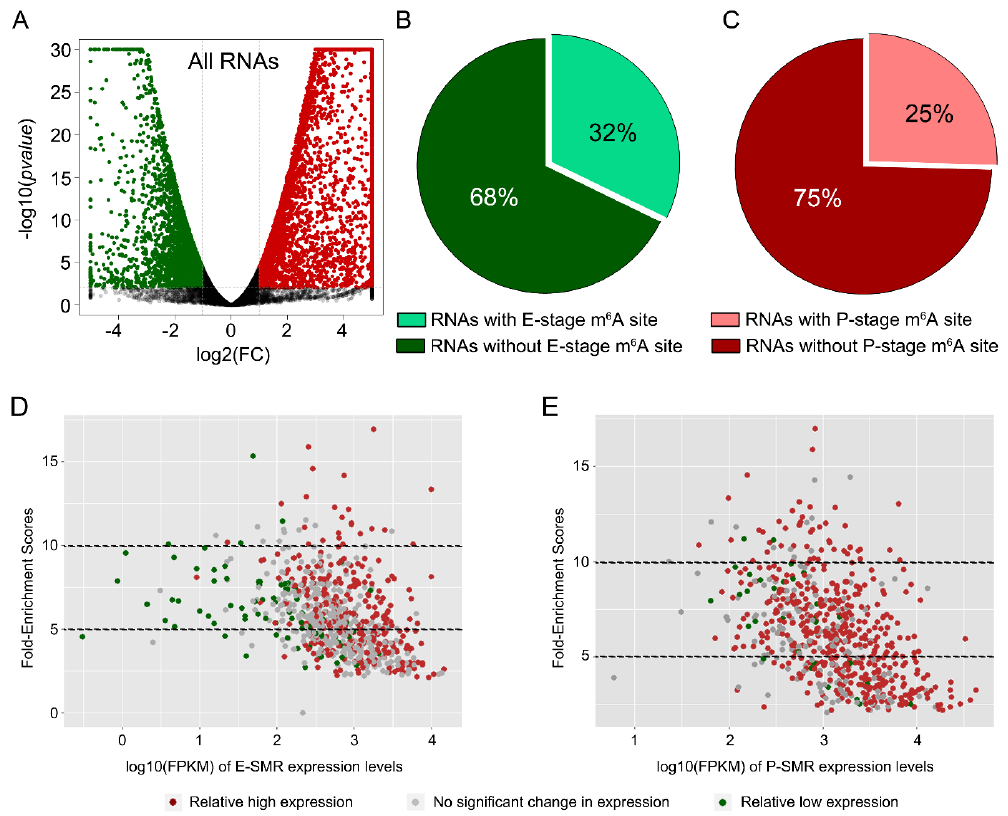
Figure 2. None-correlation between fold enrichment of MeRIP sequencing and reads of transcriptome sequencing. ( A ) The Volcano map of transcription profiles of all RNAs in P-stage compared to E-stage. The transcriptome data were downloaded and used from (NCIB GEO: GSE116056). ( B ) The proportion of down-regulated RNAs with or without an E-stage m 6 A site. ( C ) The proportion of up-regulated RNAs with or without a P-stage m 6 A site. ( D , E ) The correlation analysis of embryonic stage-specifically methylated RNAs (E-SMRs) or postnatal stage-specifically methylated RNAs (P-SMRs) between their fold enrichment score values of m 6 A-methylation levels and the FPKM reads of their expression levels.